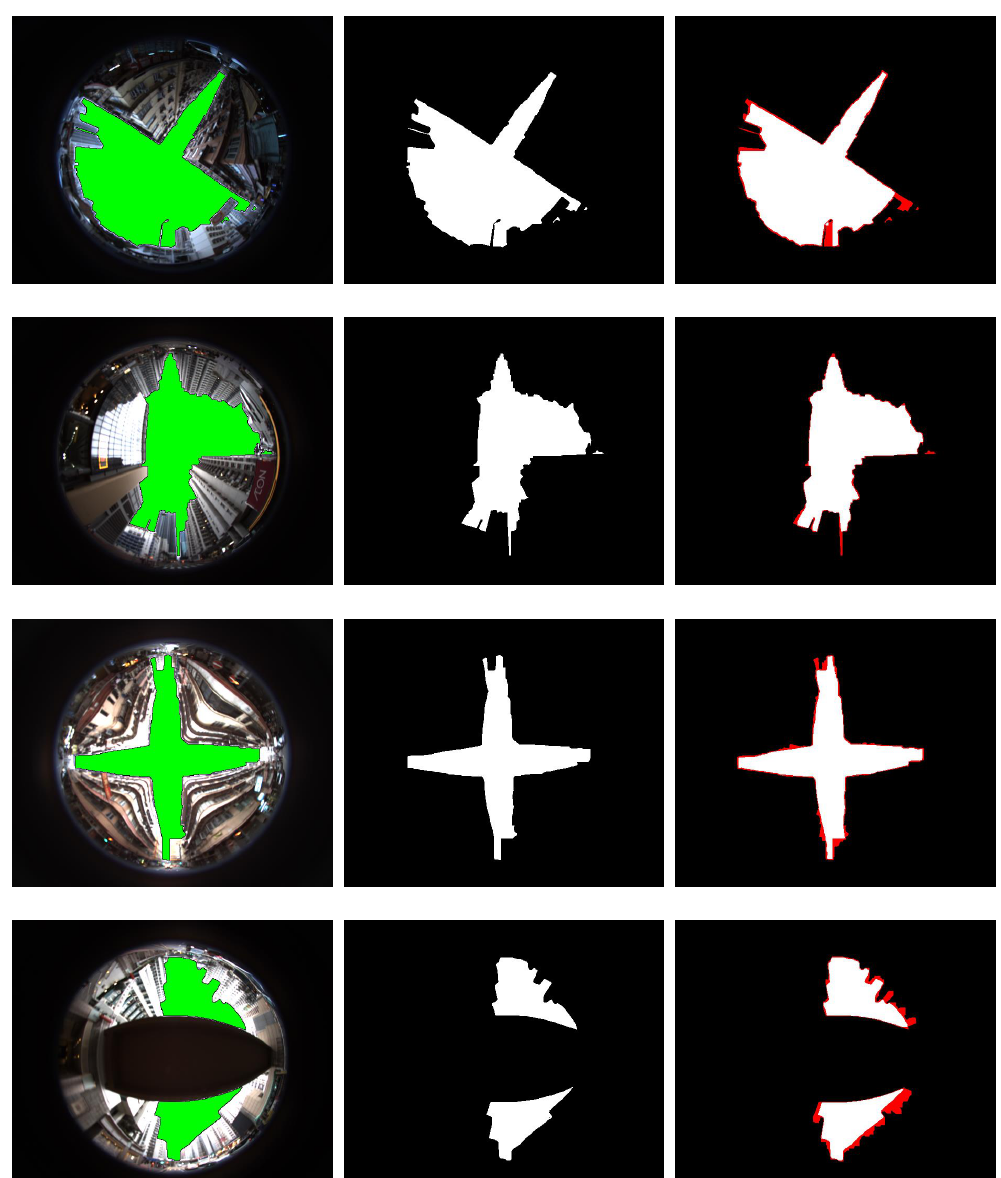
Figure 13. Quantitative evaluation of sky region segmentation. The first column shows the images containing the truth values of the sky regions that we extracted manually. The second column shows the benchmark images. The third column shows the results of our sky region segmentation algorithm, where the red pixels represent the parts of the sky region that are incorrectly detected by our